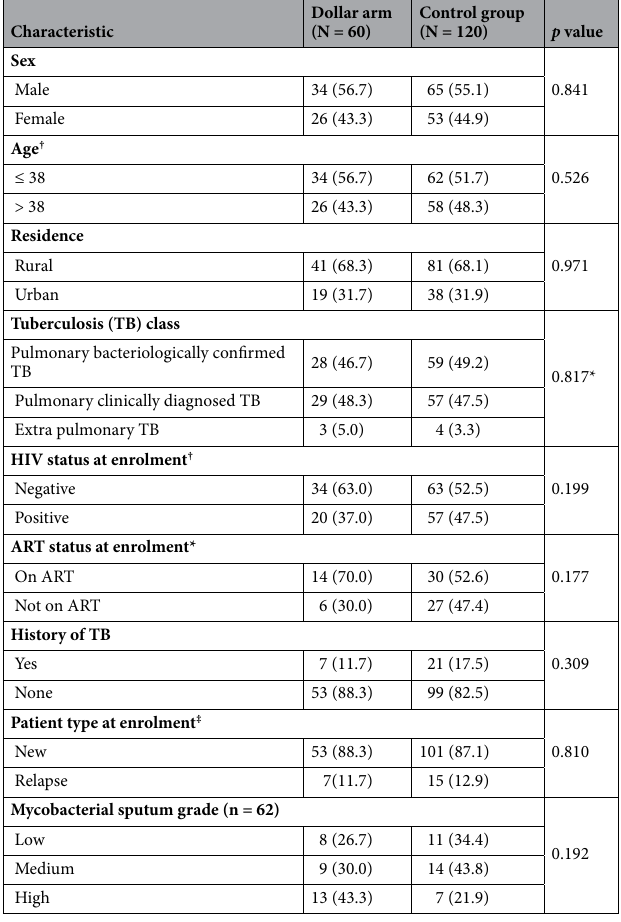
Table 1. Baseline characteristics of study participants. *n = 20 for Dollar arm and n = 57 Control group. † For 6 participants in the Dollar arm, the HIV status was unknown, ART—antiretroviral therapy, PTB—pulmonary tuberculosis. ‡ For 7 participants with the Control group, the patient type was unknown. † Age was categorised according to the median age of the